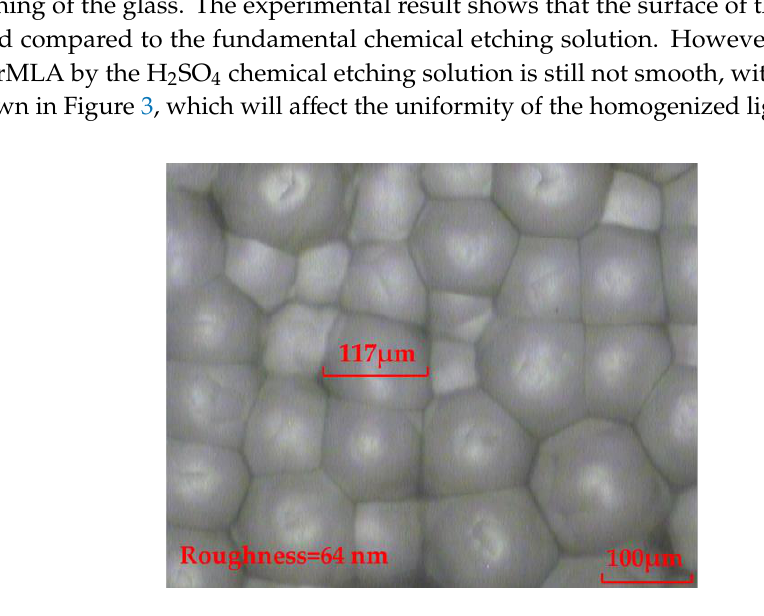
2 SO 4 chemical etching